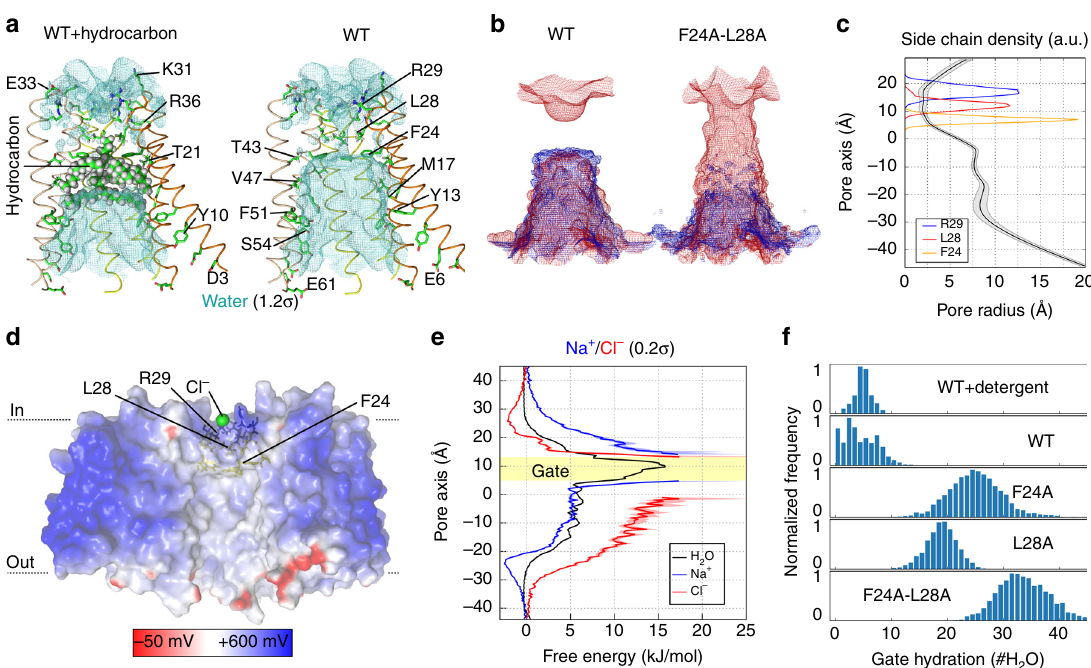
Fig. 6 MD simulations reveal a closed anion permeation pathway. a Averaged water densities in absence or presence of the hydrocarbon chain along the central axis from unguided MD simulations contoured at 1.2 σ in side view. Helices A and B of three subunits are shown in cartoon representation and pore- lining residues as sticks. b Na + (blue) and Cl − (red) densities for WT and F24A-L28A mutant proteins in absence of the detergent contoured at 0.2 σ . c Pore radii along the pore axis (positions relative to the protein center of mass) for the conformational ensemble sampled in WT simulations without hydrocarbon chain. Side chain positions of residues Phe24, Leu28, and Arg29 are shown. d Electrostatic potential distribution calculated from the MD simulations mapped onto the solvent-accessible surface of OLPVRII in side view. The two front subunits are hidden for clarity. e Potential of mean force pro fi les for water, Na + , and Cl − permeation along the pore. f Histograms of the number of water molecules observed within the hydrophobic gate region for different mutations. Source data are provided as a Source Data fi